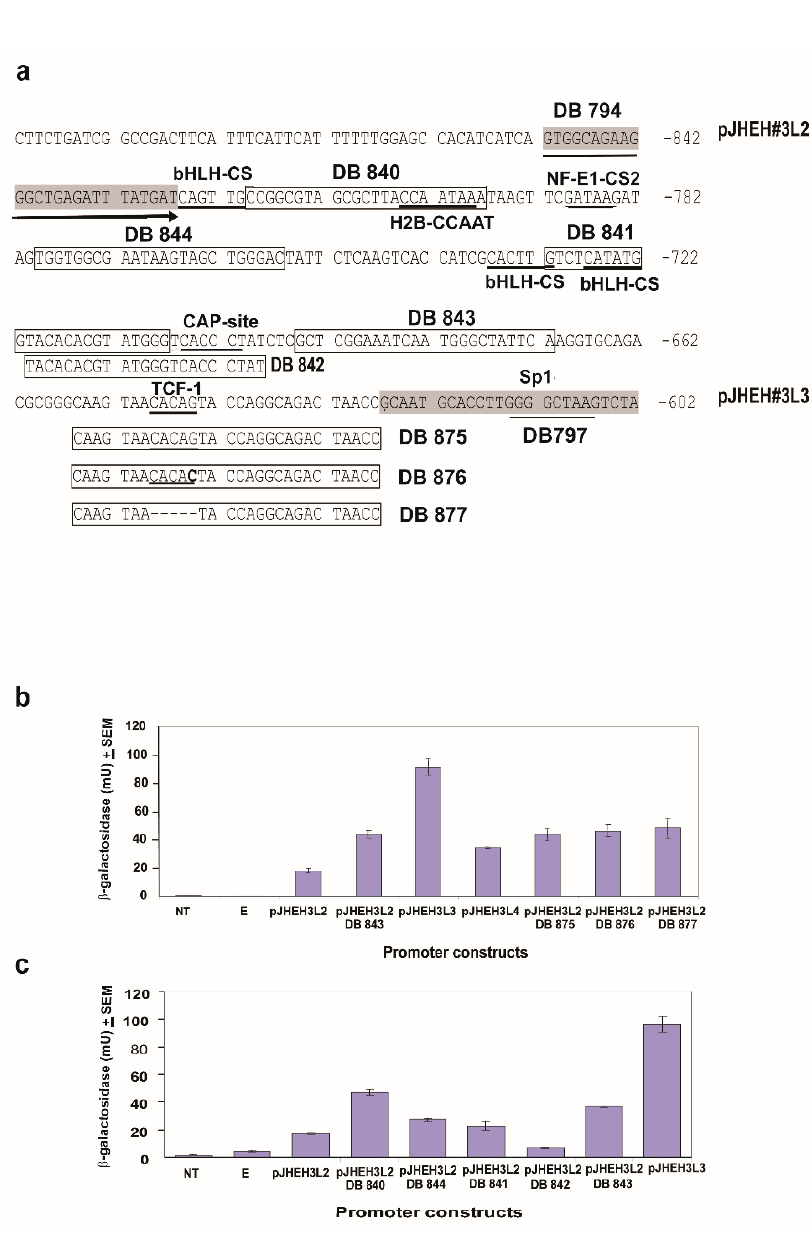
Figure 8. Testing promoter sequence (225 bp) between pJHEH#3L2 and pJHEH#3L3 ( a ) for TFs DNA-binding sequences and effects on jheh 3 promoter transcriptional activities, as shown in Figure 7, by testing different promoter lengths and mutating or deleting TF TCF-1 DNA-binding site using primers DB877 and DB876, respectively ( b , c ).